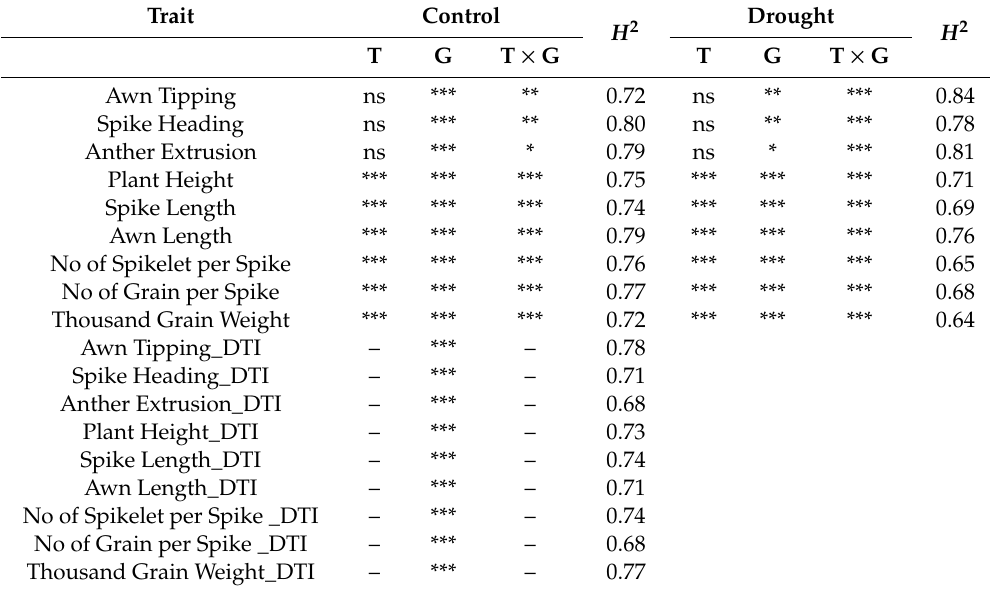
Analysis of variance and heritability for the measured traits under control and drought